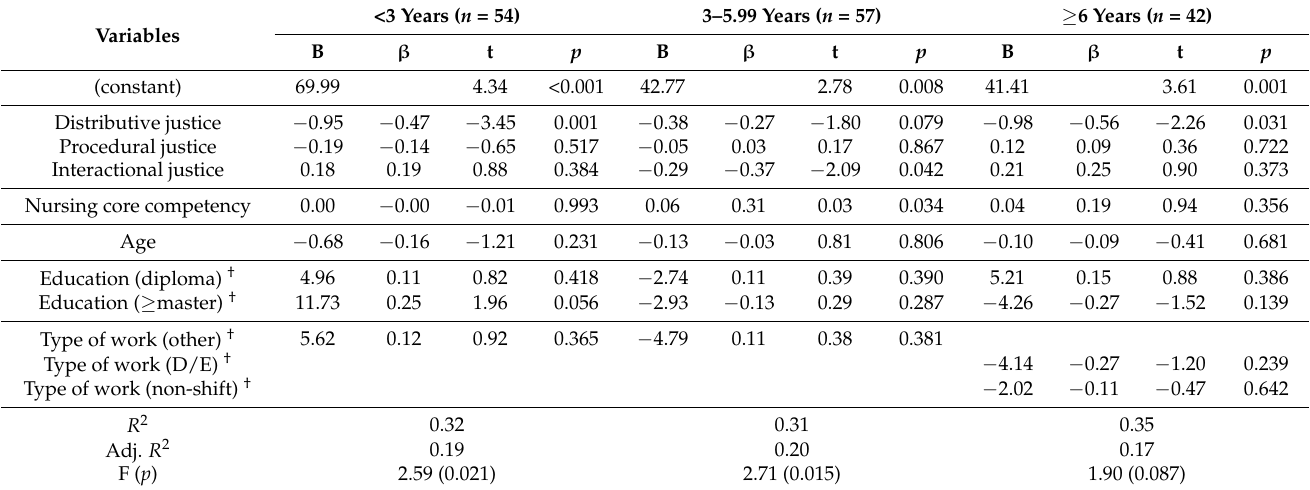
Table 4. Factors influencing turnover intention by clinical experience ( N =